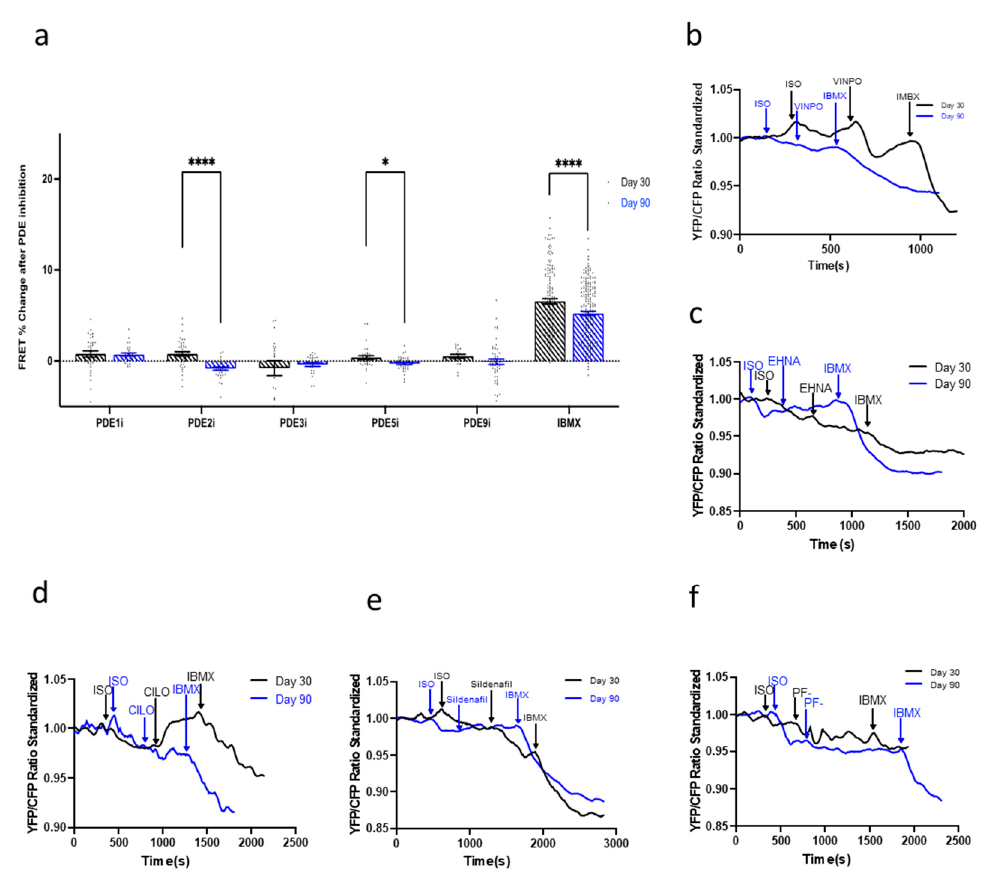
Figure 7. ( a ) The regulation of the β 3 -adrenoreceptor (AR)-cGMP pathway by PDEs throughout the aging of hiPSC-CMs in culture from day 30 to day 90. Model traces of cGMP production after the inhibition of β 1 - and β 2 -AR and situation of β 3 via isoproterenol (ISO) and subsequent ( b ) PDE1 inhibition via vinpocetine (VIMPO), ( c ) PDE2 inhibition via EHNA, ( d ) PDE3 inhibition via Cilostamine (CILO), ( e ) PDE5 inhibition via Sildenafil, and ( f ) PDE9 inhibition via PF-04447943 (PF-), and saturation via 3-isobutyl-1-methylxanthine (IBMX). All data is composed of three independent experimental batches. *—p < 0.1; ****—p < 0.0001